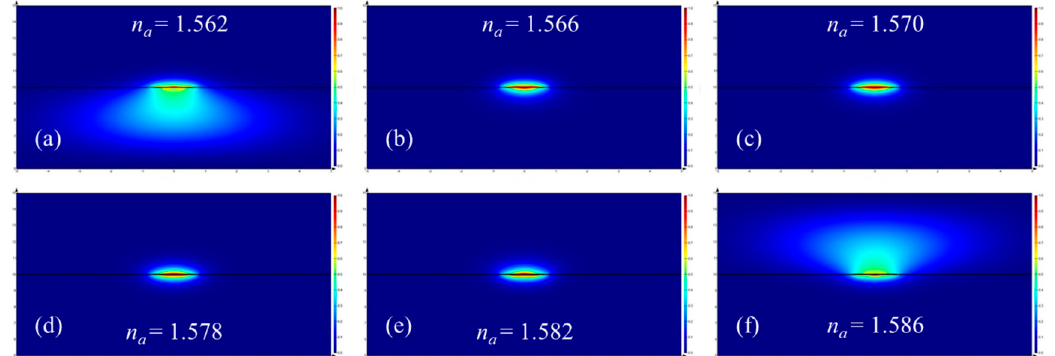
Figure 7. Distribution of the vertical transverse electric field component ( E y ) of the fundamental LRSPP mode for different cases of RI ( a ) 1.562, ( b ) 1.566, ( c ) 1.570, ( d ) 1.578, ( e ) 1.582 and ( f ) 1.586 in the fluidic channel ( n a ). Here, the width and thickness of the Au stripe are 1.5 μ m and 25 nm, respectively.